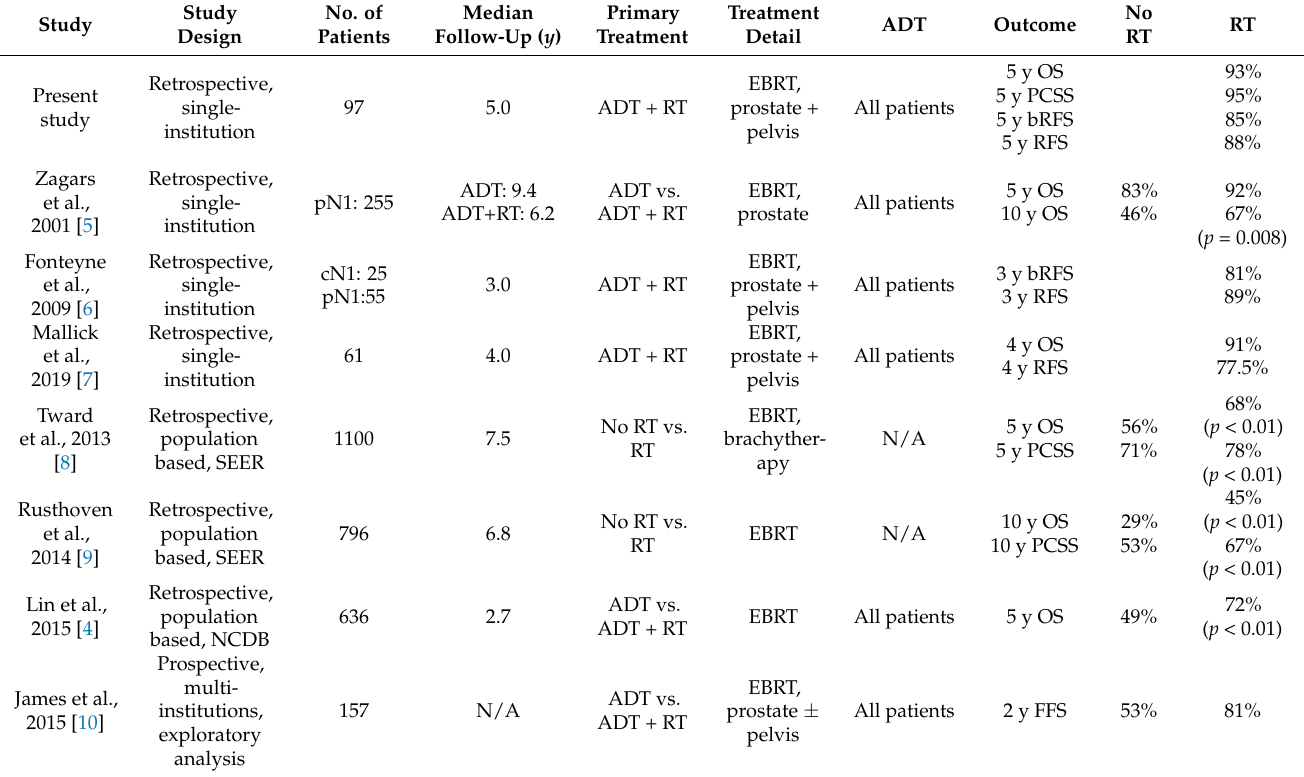
Table 5. Previous studies on prostate cancer